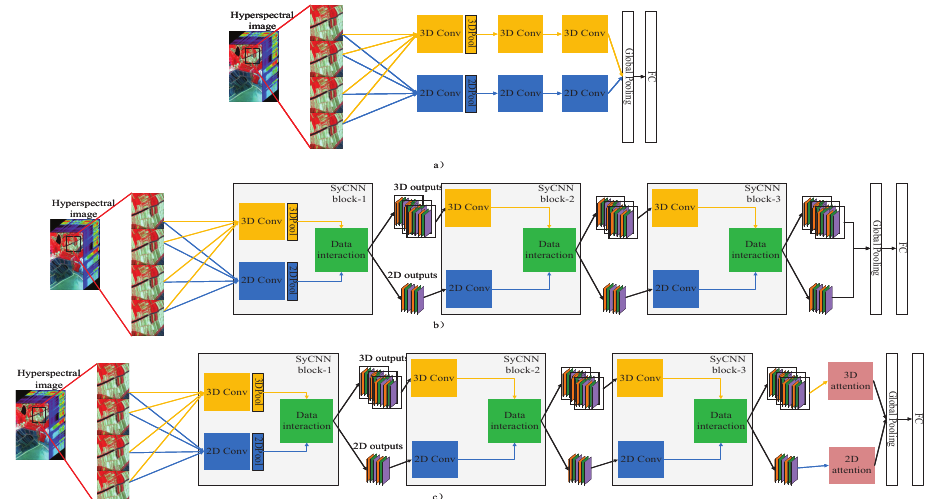
Figure 4. Illustration of the proposed models: ( a ) The deep simple SyCNN model, ( b ) the deep SyCNN model, ( c ) the deep SyCNN with attention module. Yellow blocks and blue blocks refer to 3D convolution and 2D convolution. Green blocks refer to data interaction